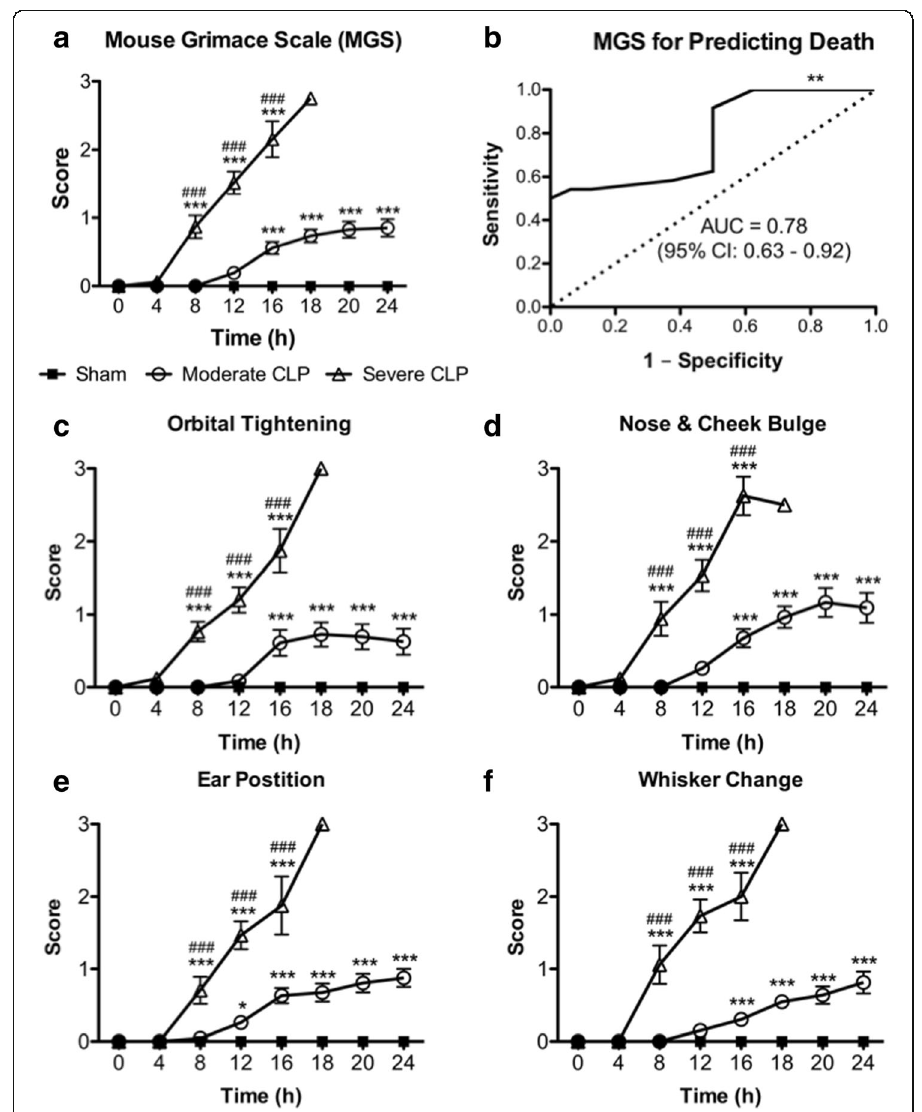
Fig. 2 Modified Mouse Grimace Scale (MGS) score over time ( a ), MGS score as a predictor of death in septic mice ( b ), and MGS individual component scores ( c – f ) over time in mice undergoing moderate or severe CLP. Data are presented as mean ± SEM from six independent experiments representing a total number of n = 18 sham, n = 23 moderate CLP, and n = 17 severe CLP mice; * p < 0.05, ** p < 0.01 (vs. line of identity in ( b )), *** p < 0.001 vs. sham; ### p < 0.001 vs. moderate CLP, by two-way ANOVA. Note: Only two mice undergoing severe CLP survived past 18 h, therefore statistical comparisons were not performed at this time-point ( a , c – f ). Dotted line in ( b ) represents the line of identity for statistical comparison in ROC analyses. AUC area under the curve, 95 % CI 95% confidence